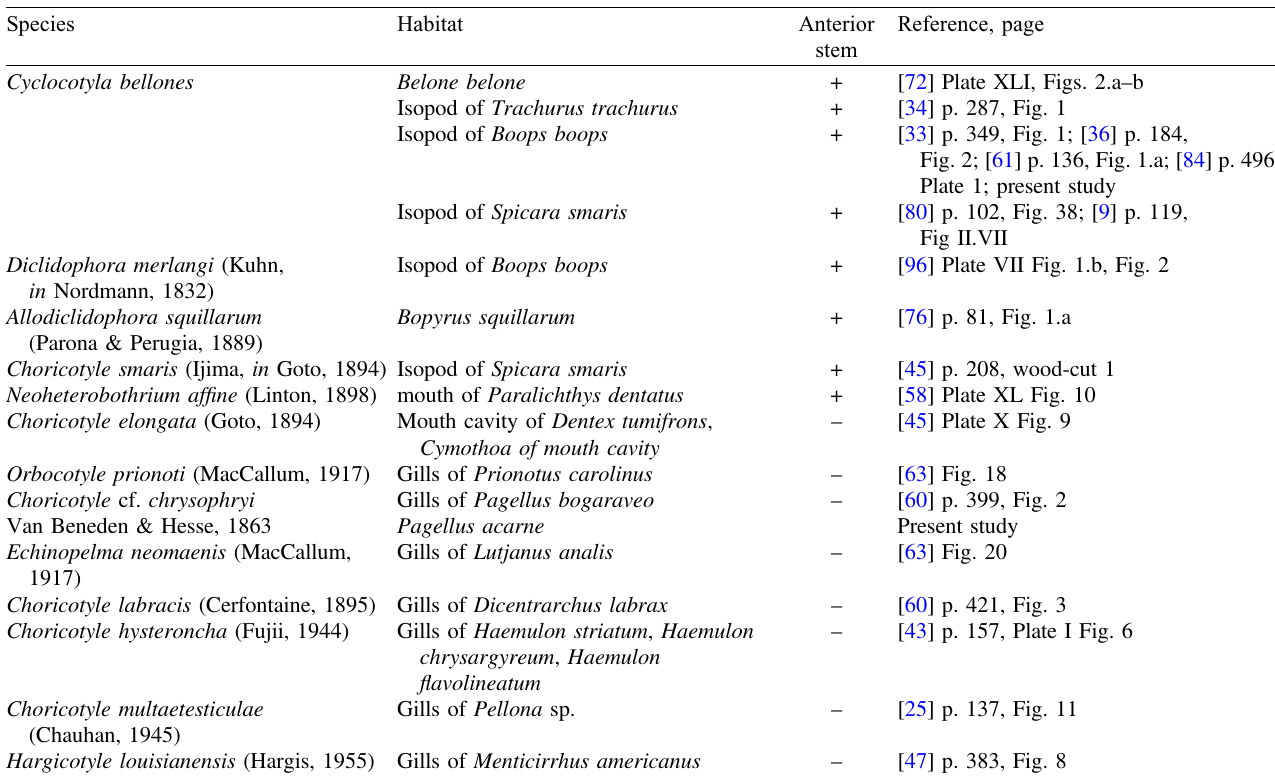
Figure 7. General body shapes of two closely related diclidophorids, Cyclocotyla bellones (A) (MNHN HEL1312, 1314-16, 1318-21) and Choricotyle cf. chrysophryi (B) (MNHN Table 2. Diclidophorids from isopods, mouth and gills, used for body comparison. +, present. – , absent.